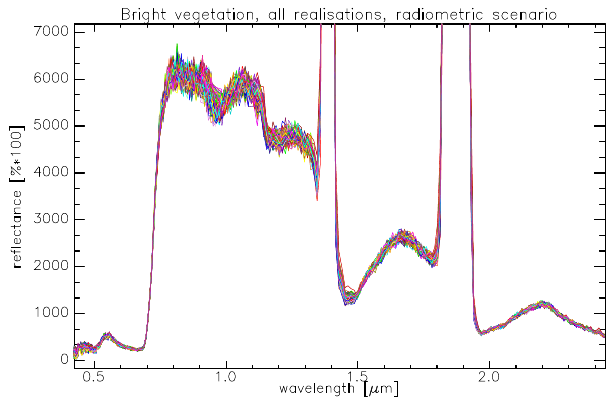
Figure 4. Plot of all realisations for the ROI “bright